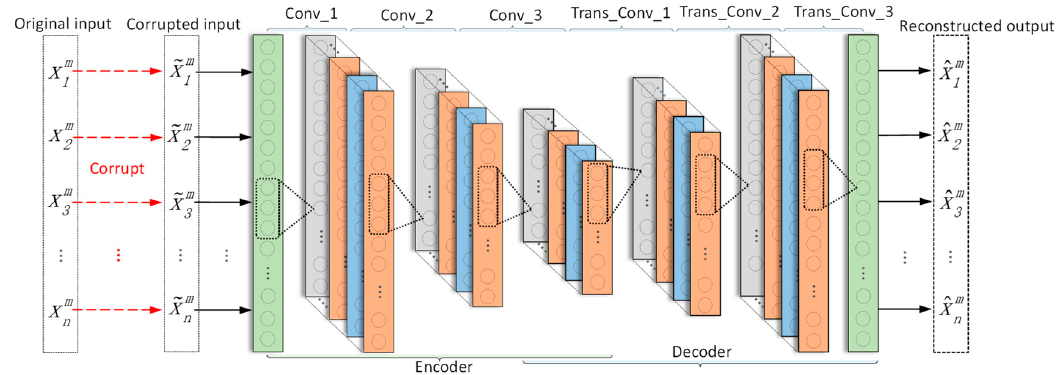
Figure 2. Structure of a 1-D denoising convolutional autoencoder.